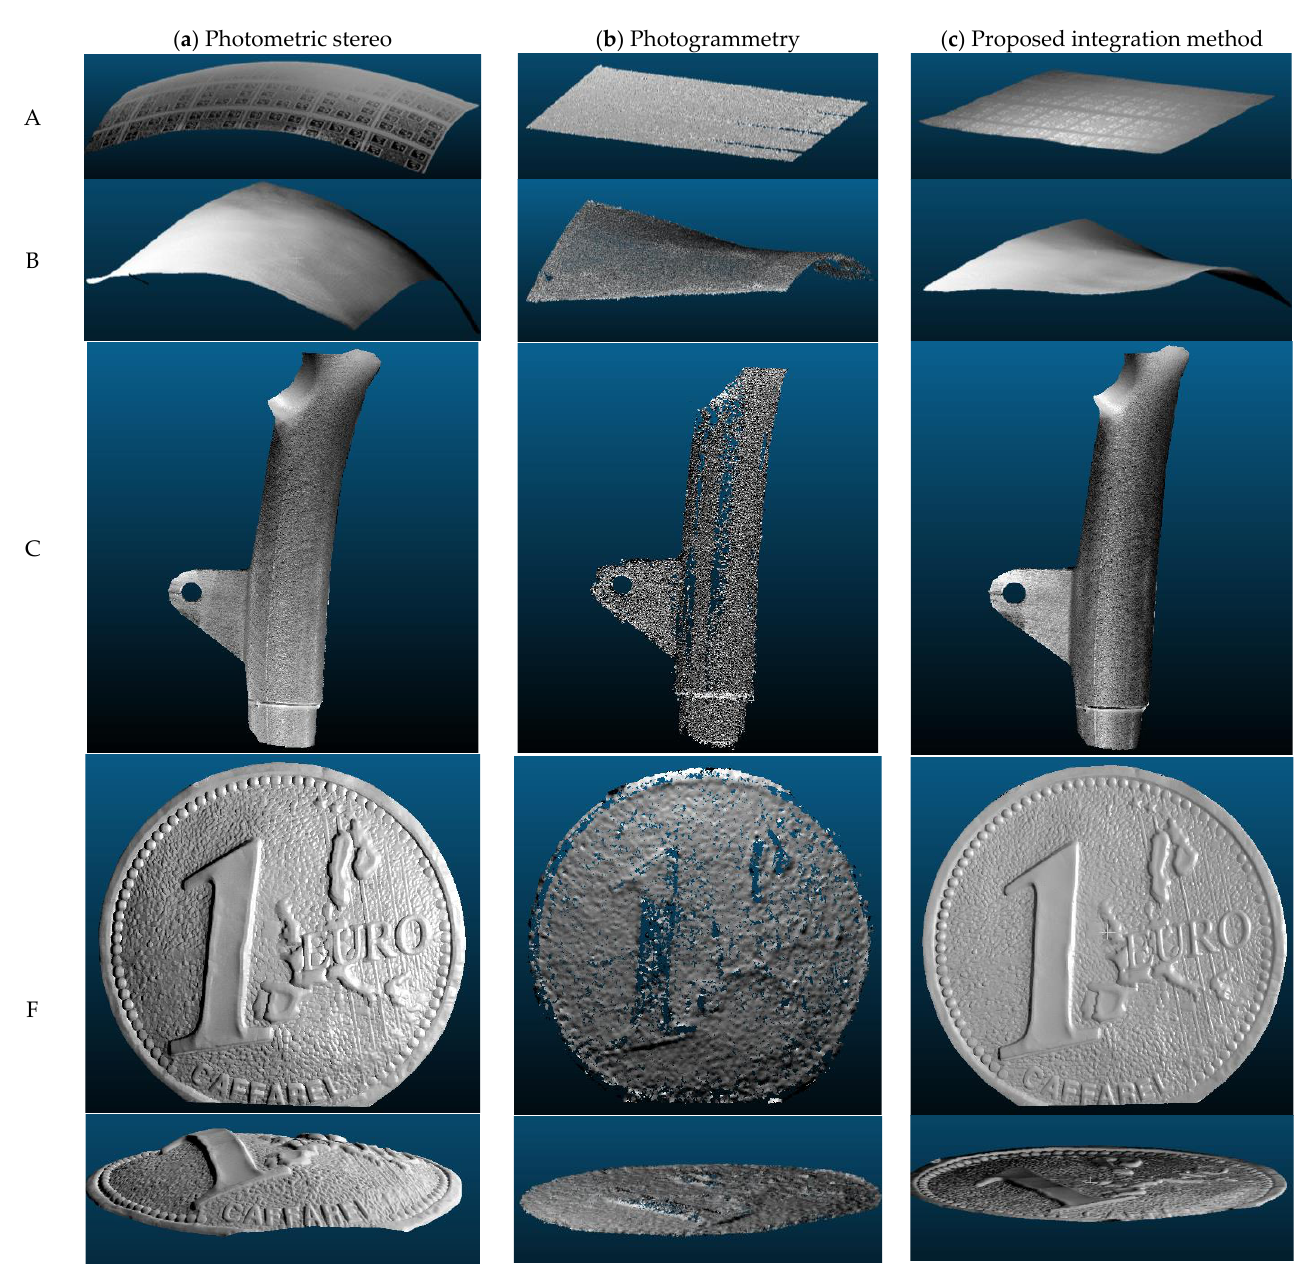
Figure 10. 3D reconstruction generated using basic photometric stereo ( a ), photogrammetry ( b ), and proposed integration method ( c ) on four different non-collaborative objects (A – C and F).